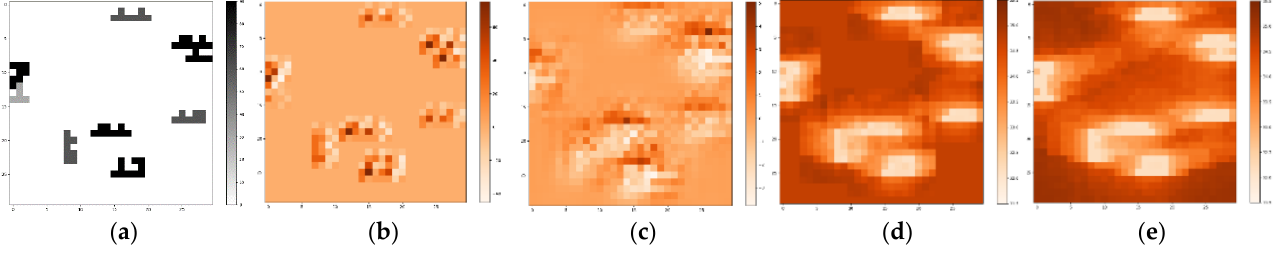
Figure 14. Schematic diagram of neural network prediction principle .